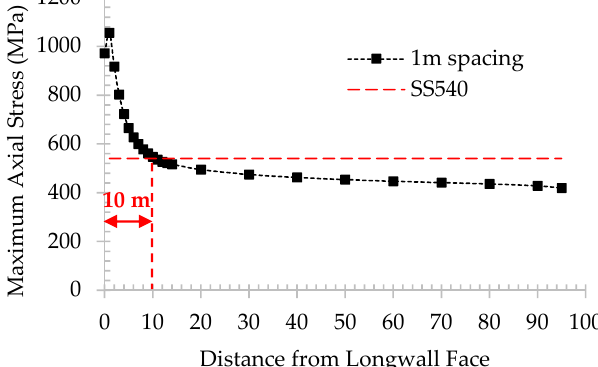
Figure 18. Maximum support axial stress along the gate-entry for 100 m of depth.